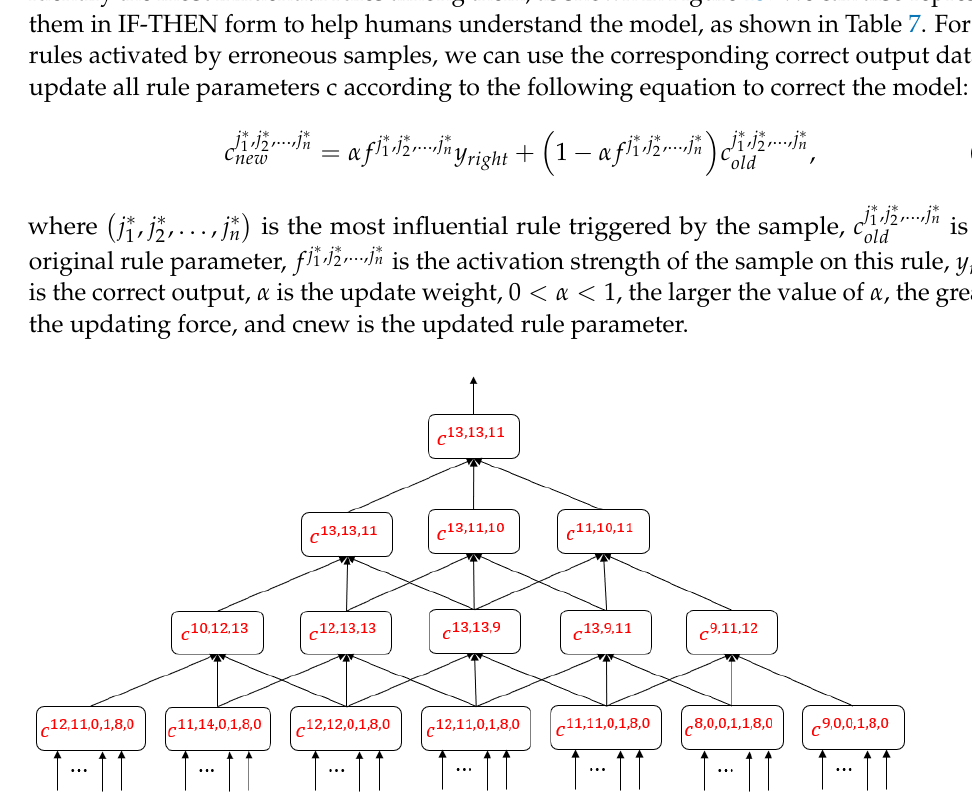
Figure 13. The rules triggered by a sample in the TaxiBJ dataset. Table 7. IF-THEN rule triggered by an input of TaxiBJ dataset in the first layer of SCDFNN. Meaning of Rule